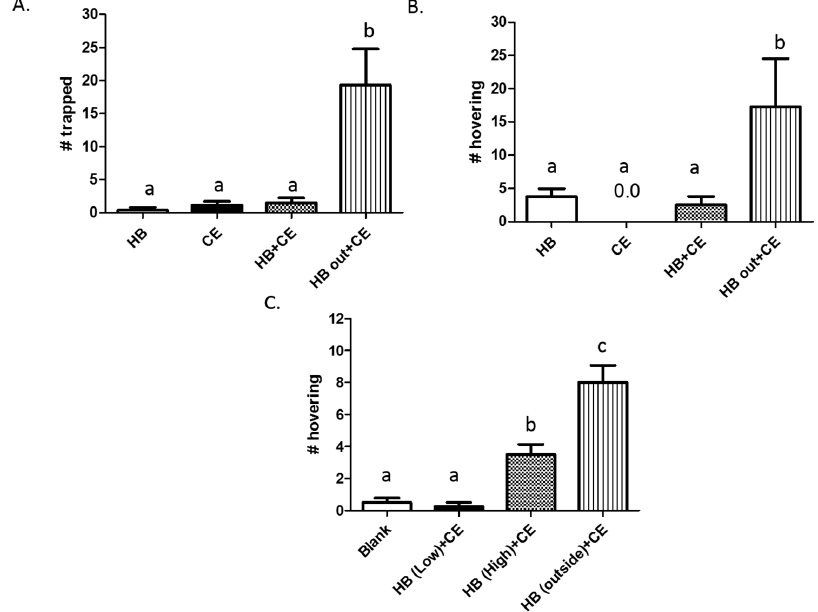
Figure 3. Partitioning of heptyl butyrate and chicken extract results in increased trapping. Traps containing heptyl butyrate (HB), chicken extract (CE), or a combination of both inside (HB + CE) were compared against traps containing CE inside and HB outside. Traps were hung at separate locations for 3 h, and the number of yellowjackets caught ( A ) or hovering around the trap ( B ) were counted. In ( C ), traps containing CE inside with low (5 µ L) or high (50 µ L) doses of HB inside, or HB on the outside (50 µ L) were hung at separate locations for 3 h, and the number of yellowjackets hovering in the vicinity were counted. Experiments were independently replicated at four to six different locations, and bars represent the mean ± SEM. Data from replicates were pooled for analysis by one-way repeated measures ANOVA followed by Newman–Keuls post-test. Differences were deemed statistically significant when p < 0.05, and are indicated by letters in the graph (same letters = no